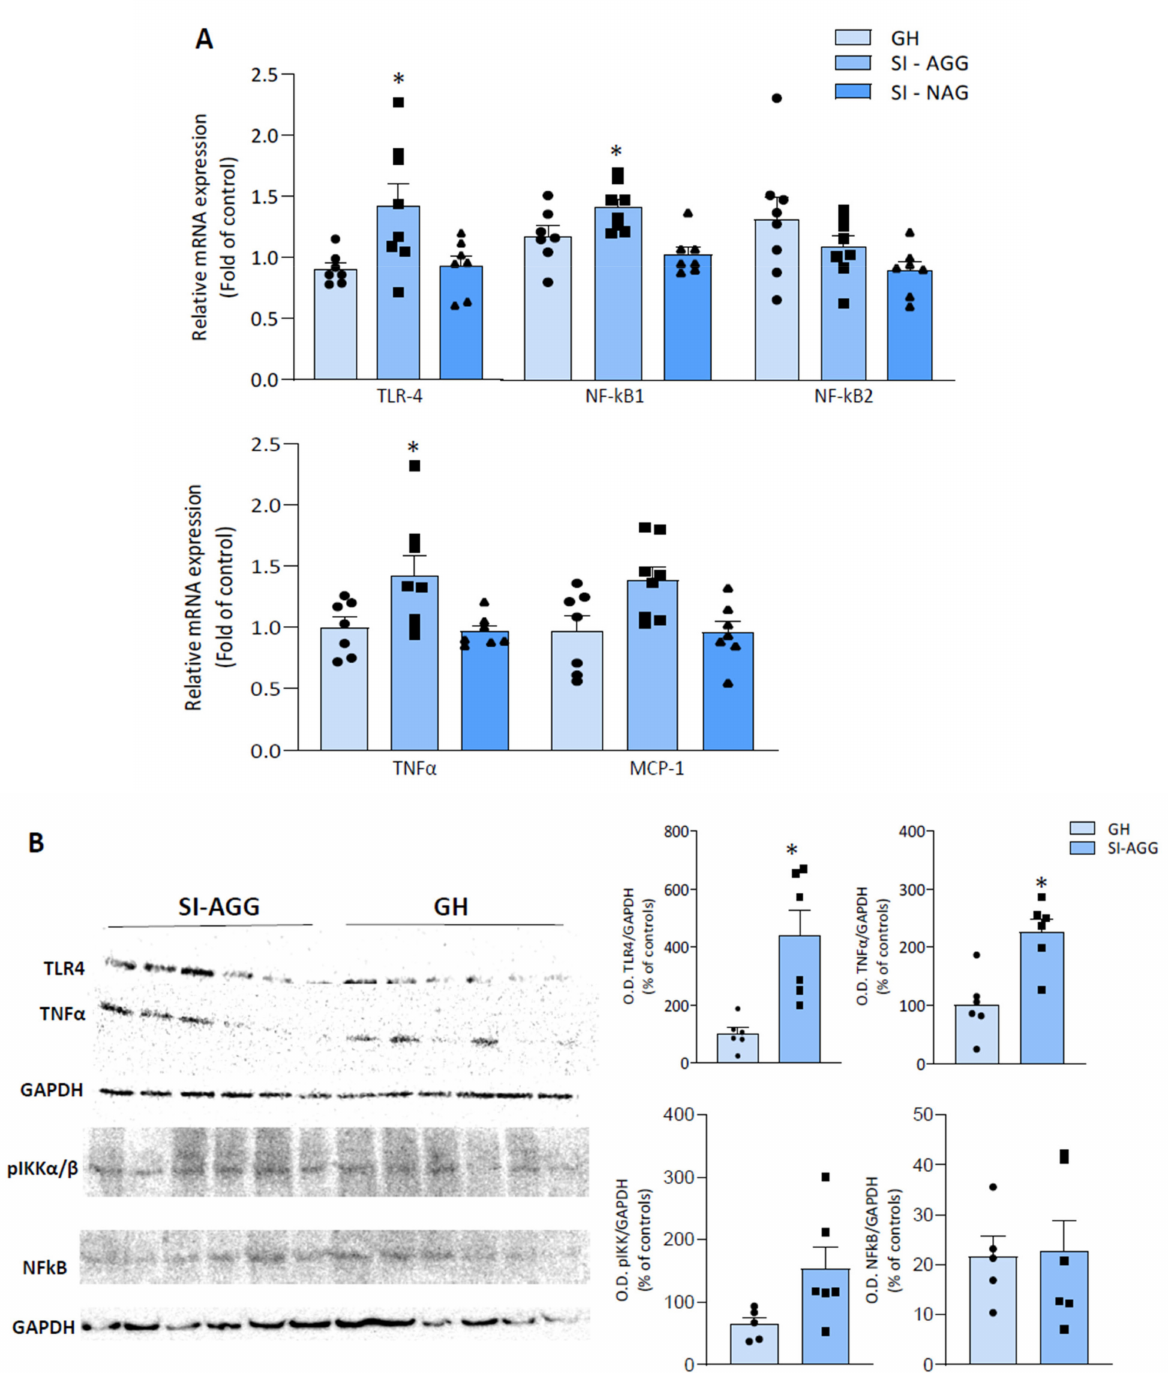
Figure 4. ( A ) TLR4, NF- κ B (1 and 2), TNF α , and MCP-1 mRNA expression in the hippocampus of SI-AGG and GH mice. Increased levels of TLR4, NF- κ B1, TNF α , and MCP1 observed in SI-AGG mice compared with GH or SI-NAG mice (one-way ANOVA: TLR4: * p = 0.03; F = 4.1; TNF α : * p = 0.01; F = 5; MCP-1: * p = 0.01, F = 4.9; NF- κ B1: * p = 0.005; F = 2; n = 7–8). No changes in NF- κ B2 were found. ( B ) Representative immunoblot for TLR4, TNF α , pIKK α / β , and NF- κ B protein expression. The optical density (OD) of the bands was quantified and normalized relative to the housekeeping protein GAPDH. The bar graphs were obtained using values as means ± S.E.M. of 5–6 samples for the controls (GH) and 6 samples for SI-AGG. The samples were loaded in the same immunoblot, and the values were calculated relative to the samples from GH mice. Individual values are shown in the relative graph plots. For the significance, values were analyzed using unpaired two-tailed t